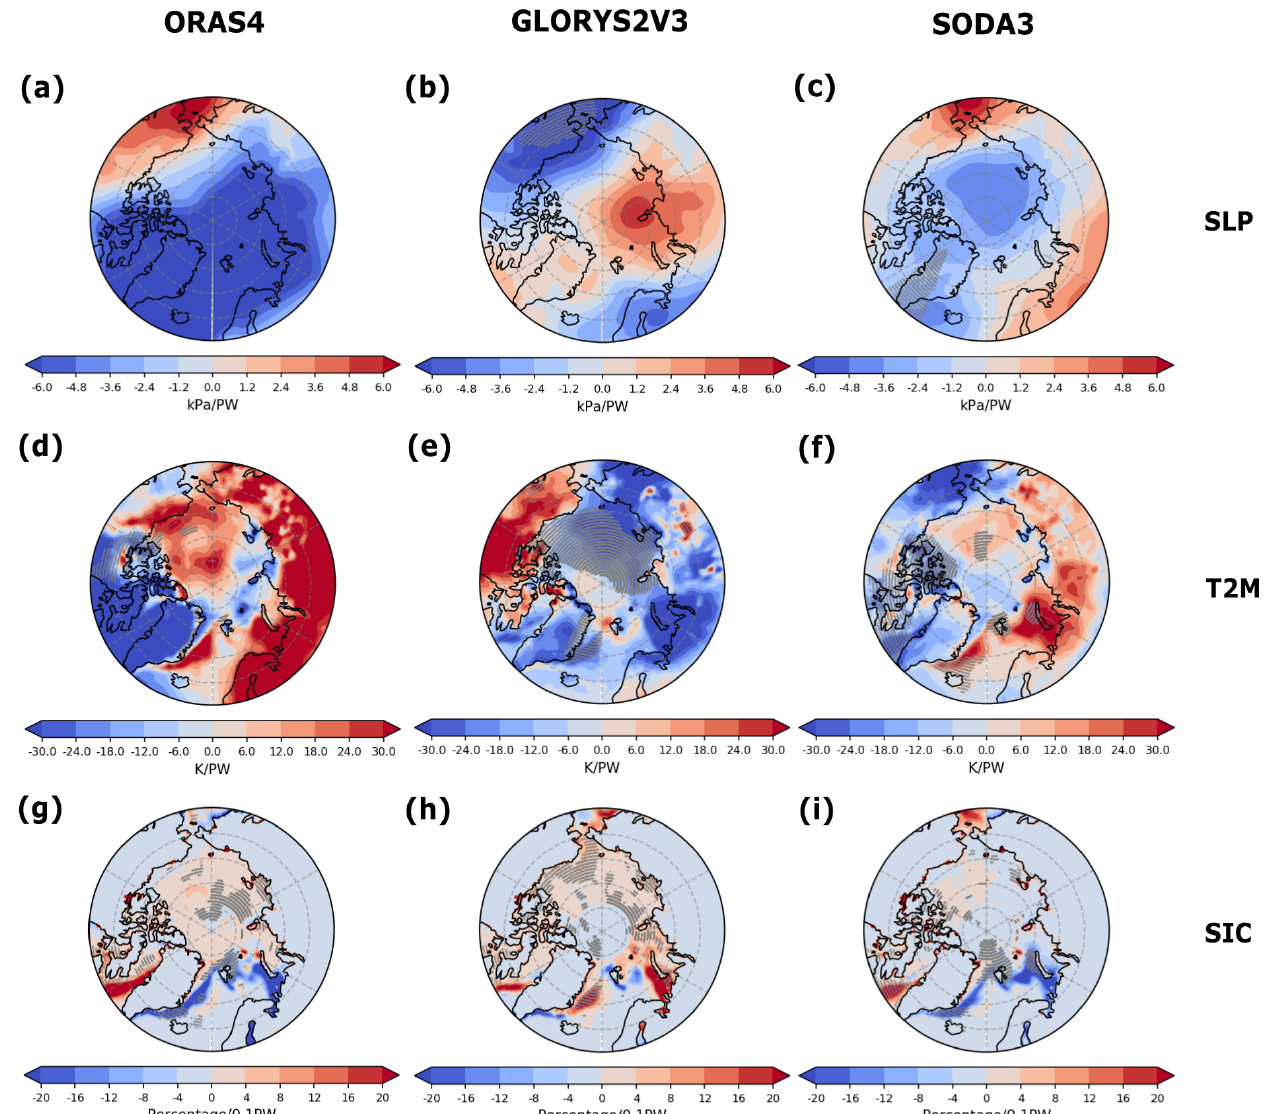
Figure 10. Regressions of sea level pressure, 2m temperature and sea ice concentration anomalies on OMET anomalies at 60 ◦ N in win- ter (DJF) at interannual timescales. OMET leads the fields by 1 month. The 2m temperature, sea ice concentration and OMET are detrended. From left to right, they are the regressions on OMET of (a, d, g) ORAS4, (b, e, h) GLORYS2V3 and (c, f, i) SODA3. The stippling indicates a significance level of